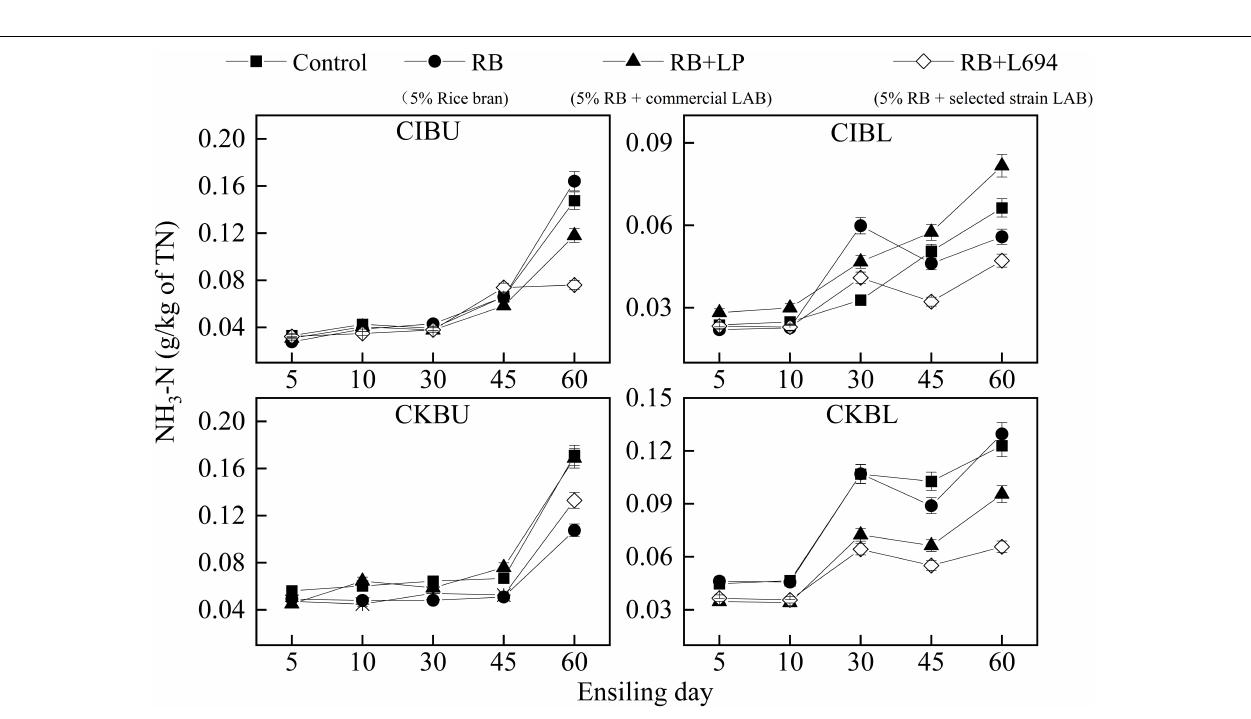
Frontiers in Microbiology |